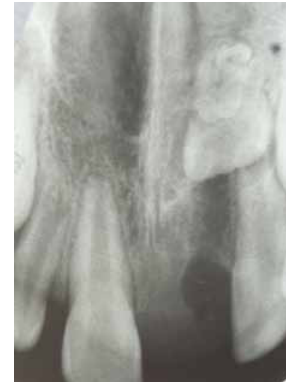
Figure 4. Case 5 (tab.1). Periapical radiograph..